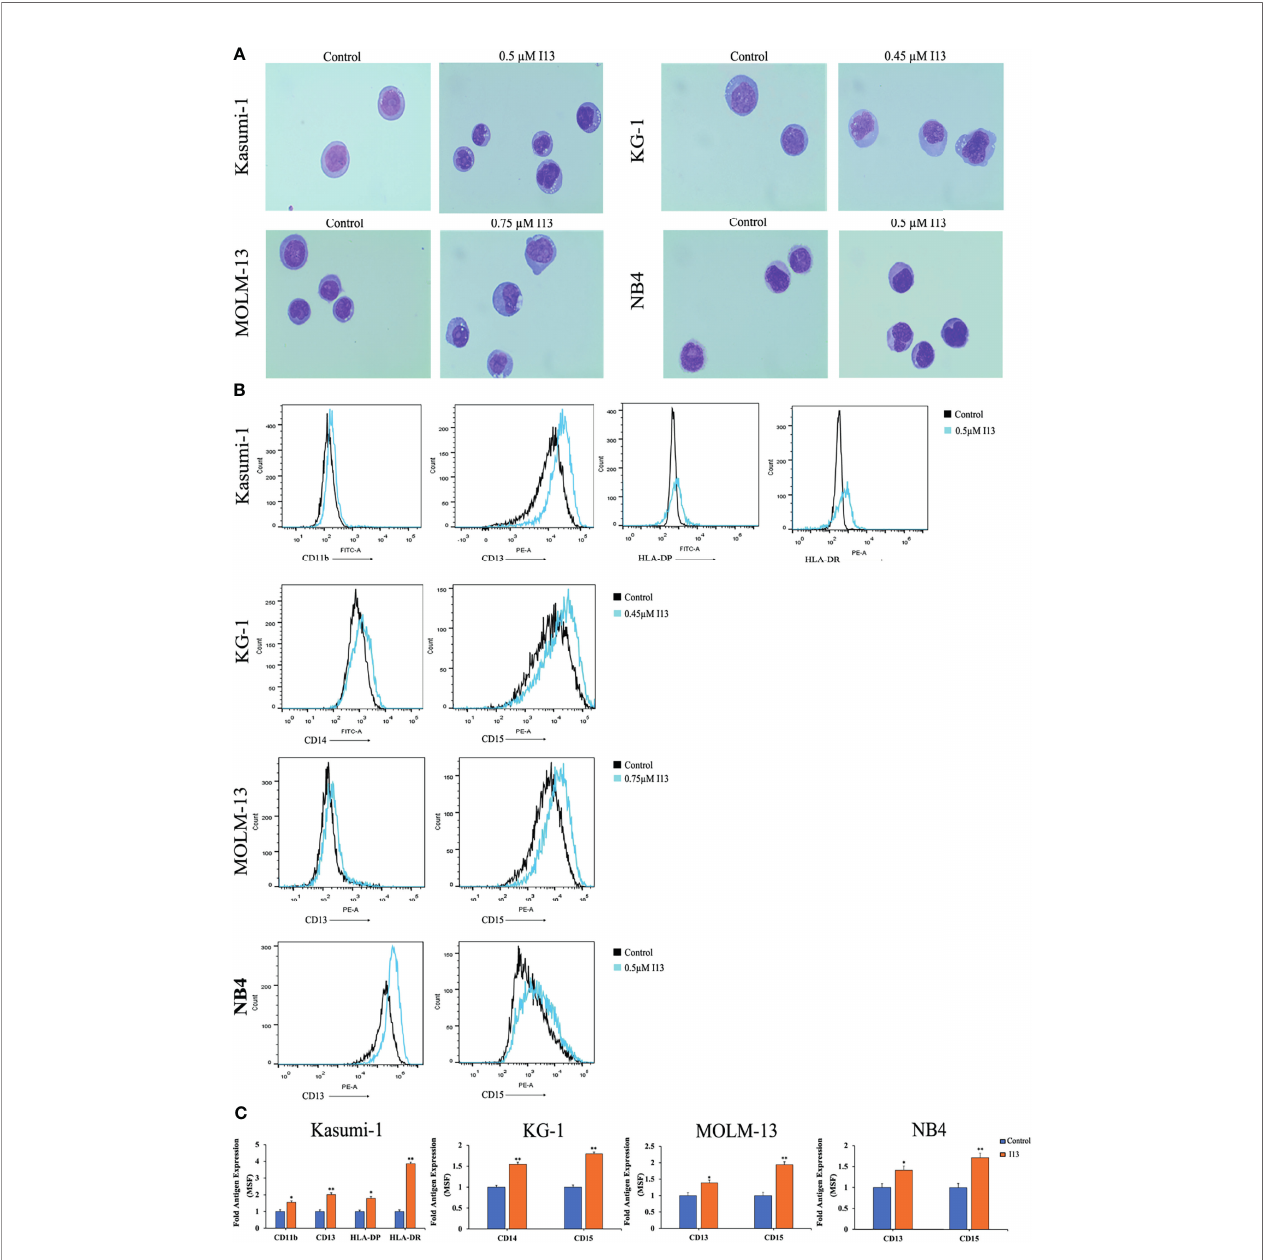
FIGURE 5 | I13 induced cell differentiation of Kasumi-1, KG-1, MOLM-13 and NB4 cells. (A) Morphological changes of Kasumi-1, KG-1, MOLM-13 and NB4 cells captured by oil immersion lens (1000×). (B, C) The expression of cell surface antigens in Kasumi-1, KG-1, MOLM-13 and NB4 cells treated with 0.5, 0.45, or 0.75 µM I13 for 72 h. (B) Mean fl uorescence intensity (MFI) of antigens. (C) A bar graph showing the statistical analysis of MFI (*p < 0.05 and **p < 0.01). The analysis was performed three